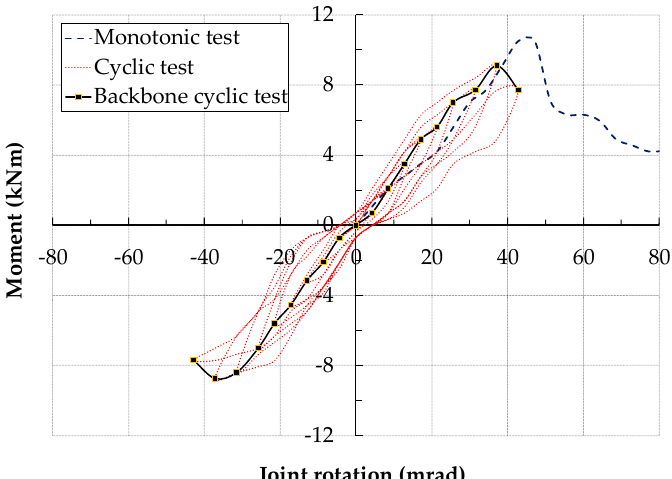
Figure 5. Cyclic moment-rotation response: SFSc2A-hybrid joint with double web and flange steel cleats.